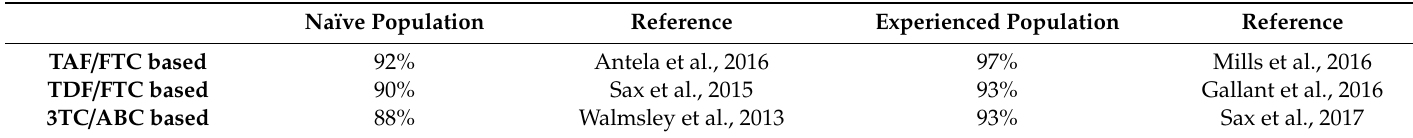
Table 3. Percentage of virologic control of the three regimens at 48